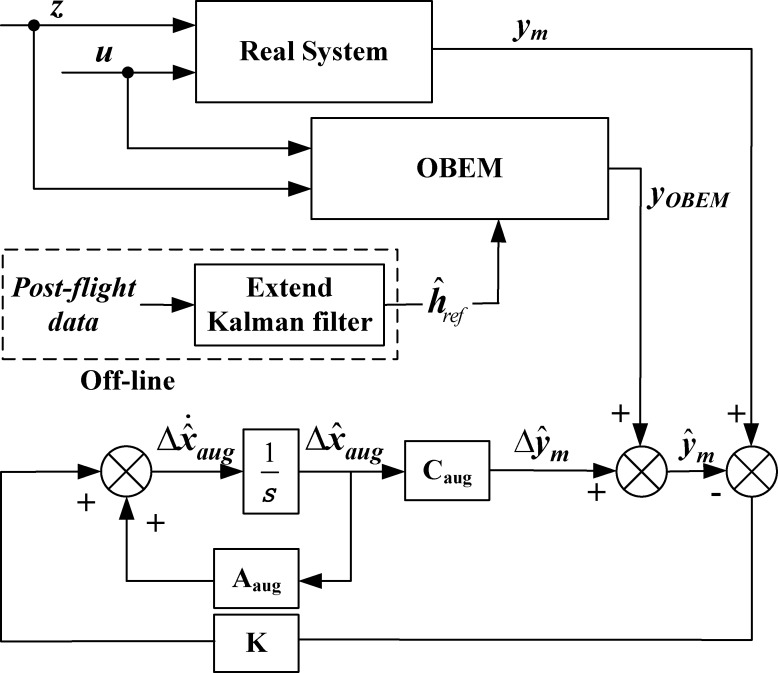
Structure of HKF.